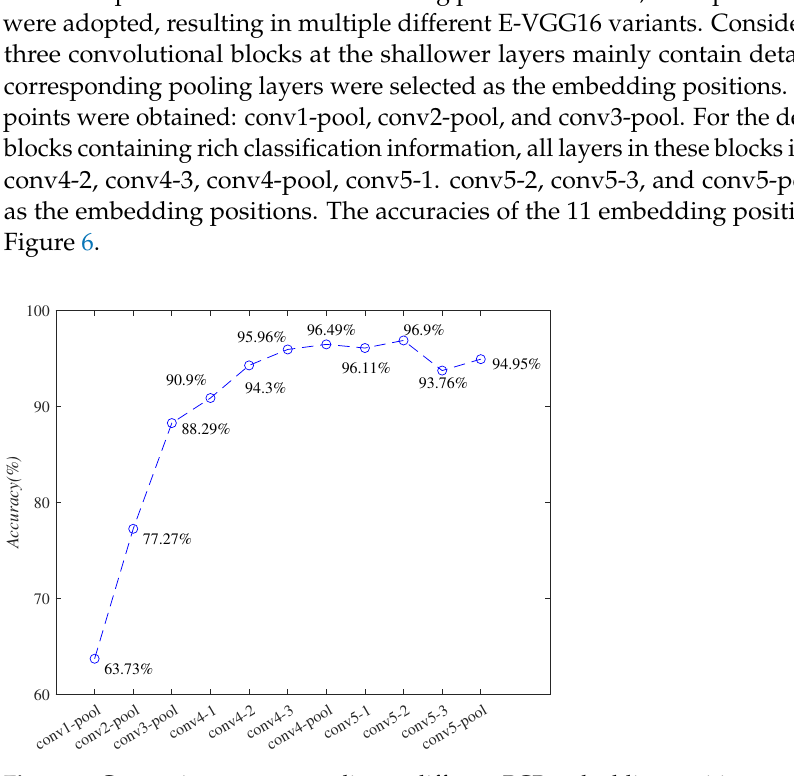
Figure 6. Comparisons corresponding to different PCB embedding